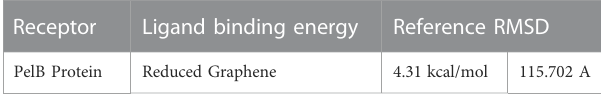
TABLE 3 Binding energy and reference RMSD values of PelB and HRG complex.